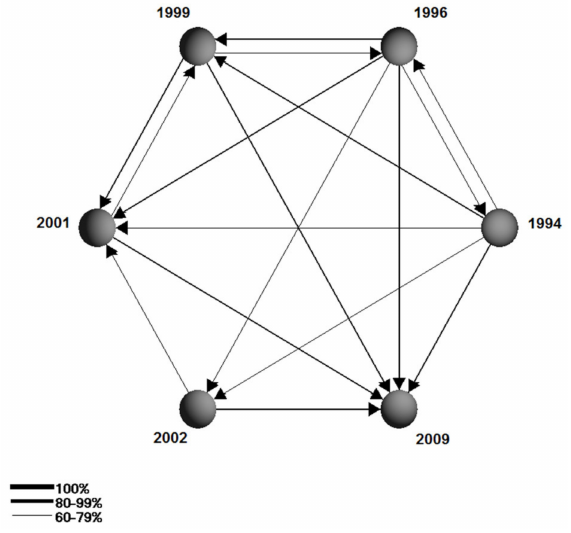
Figure 8. An oriented multigraph of binary relations, built on an array of descriptions of species composition of the zooplankton of the Ob River during the years of research.